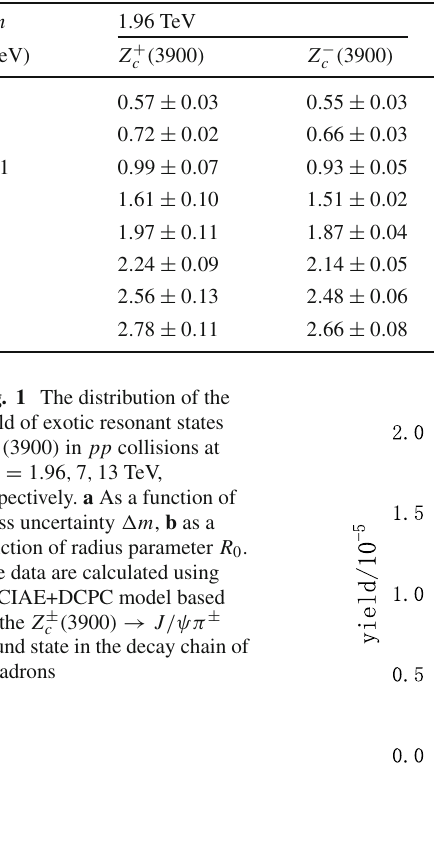
Table 2 The yields ( 10 − 6 ) of exotic resonant states Z + c ( 3900 ) and Z − c ( 3900 ) varies with parameter (cid:5) m changing from 8 MeV to 40 MeV √ s = 1 . 96 , 7 and 13 TeV. Z ± c ( 3900 ) states decaying in pp collision at